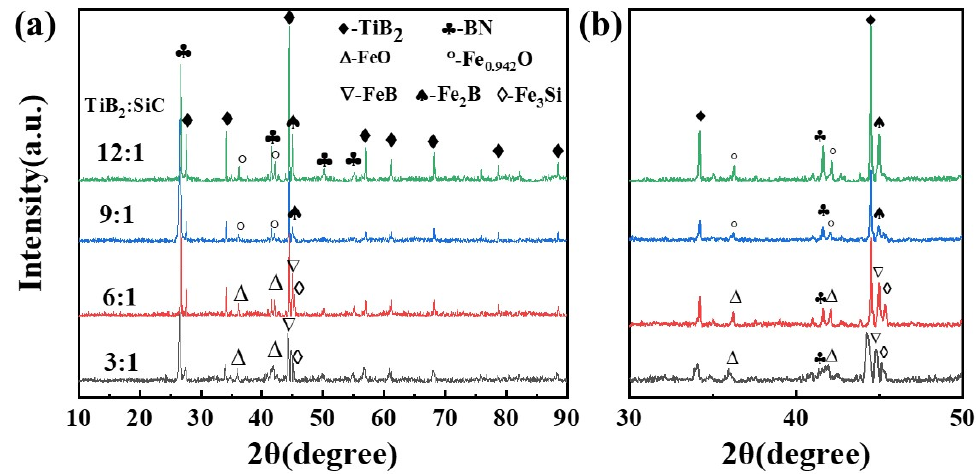
Figure 3. ( a ) XRD patterns of TiB 2 -BN-SiC composite ceramics with various TiB 2 -SiC volume ratios, (b) is their local feature.